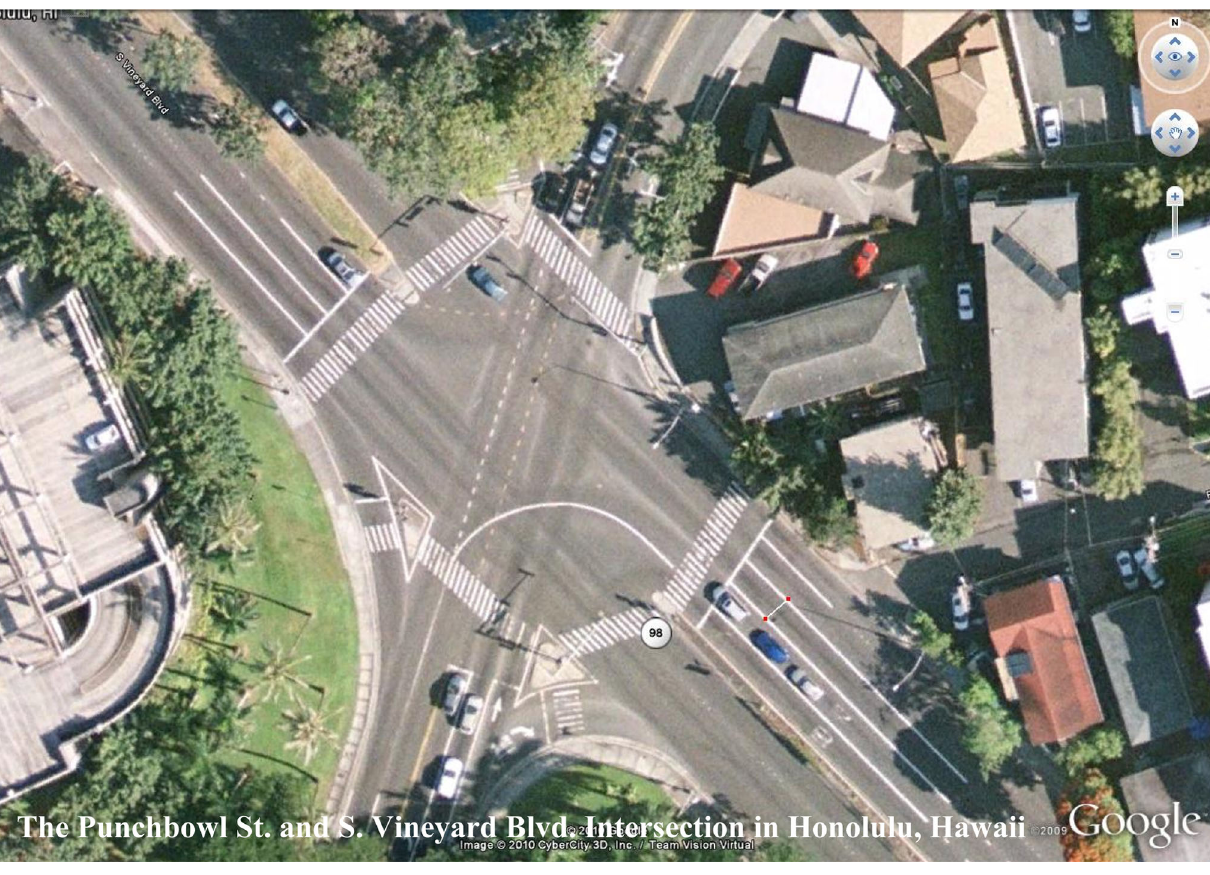
Fig. 4 Google map of study intersection